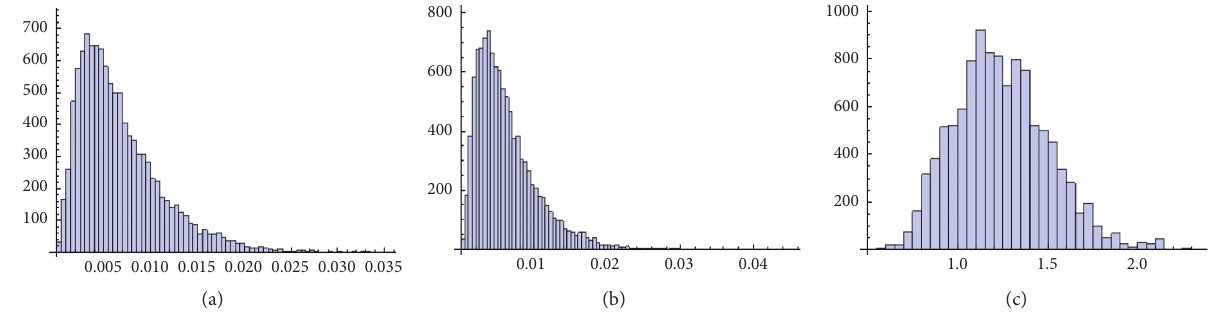
Figure 4: Histogram generated by the MCMC method for α